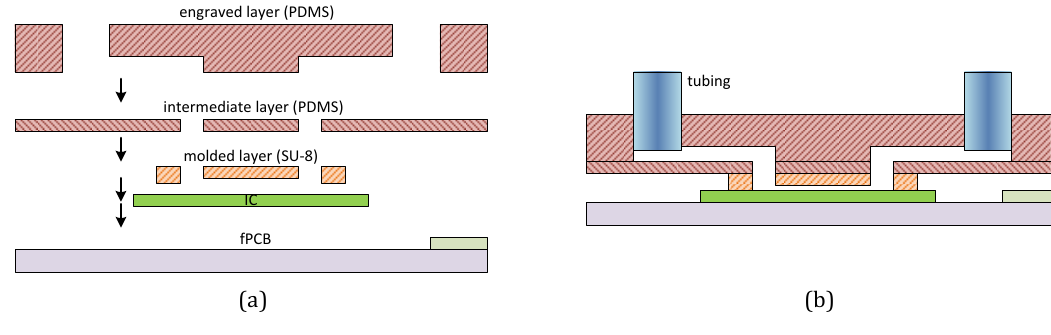
Figure 13. Hybrid soft lithography/laser engraved PDMS fabrication method (as reported in [62]).